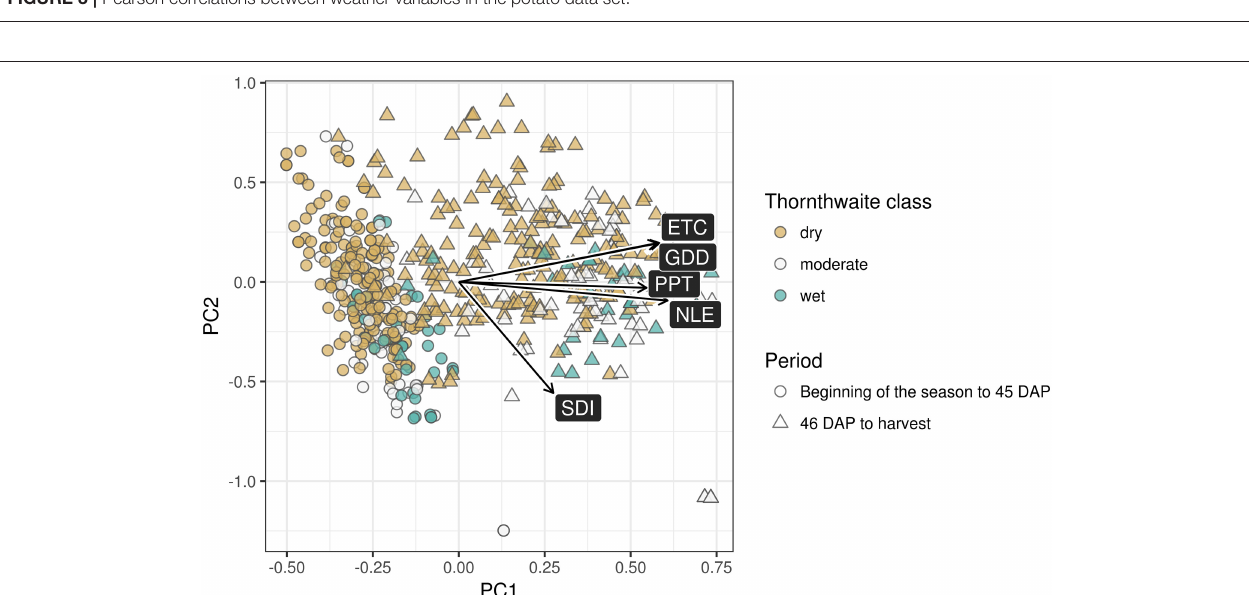
FIGURE 3 | Pearson correlations between weather variables in the potato data set.